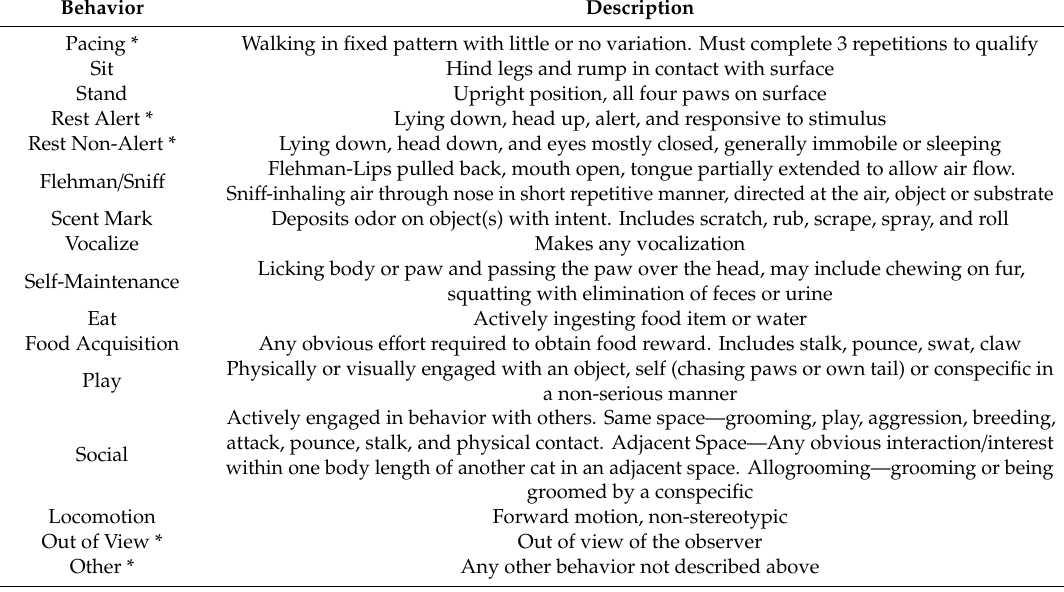
Table 4. Ethogram of Amur leopard behavior. Adapted from Stanton et al. [90].